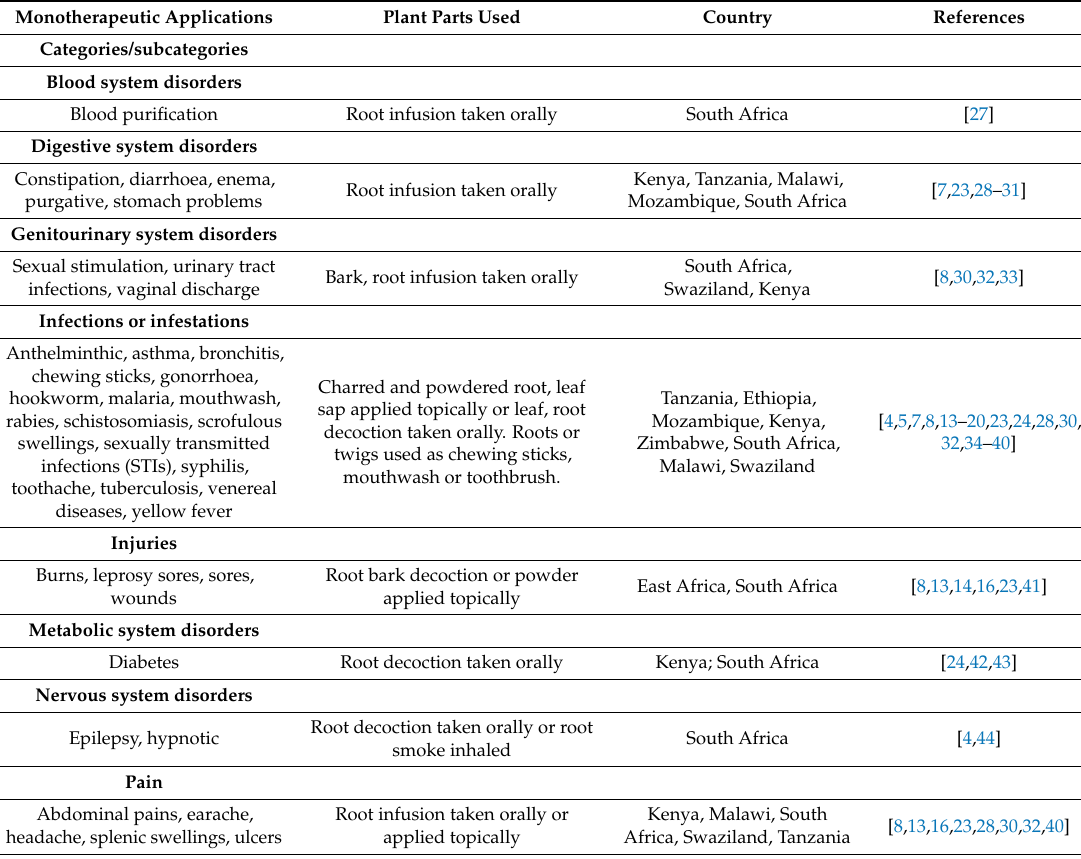
Table 1. Medicinal uses of Euclea natalensis based on ailment categories proposed by Cook [26]. Monotherapeutic Applications Plant Parts Used